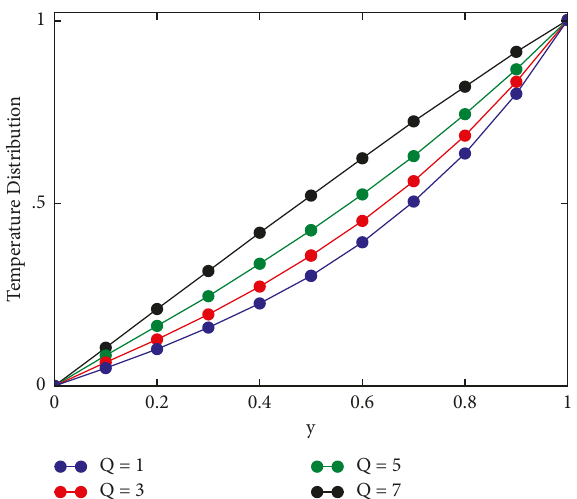
Figure 9: Effect of heat source Q on temperature when Pr